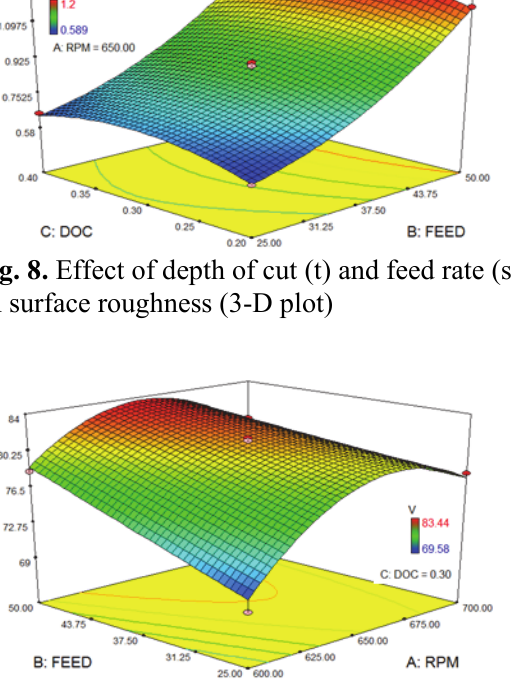
Fig. 10. Effect of spindle speed (N) and feed rate (s) on tool vibration (3-D plot)